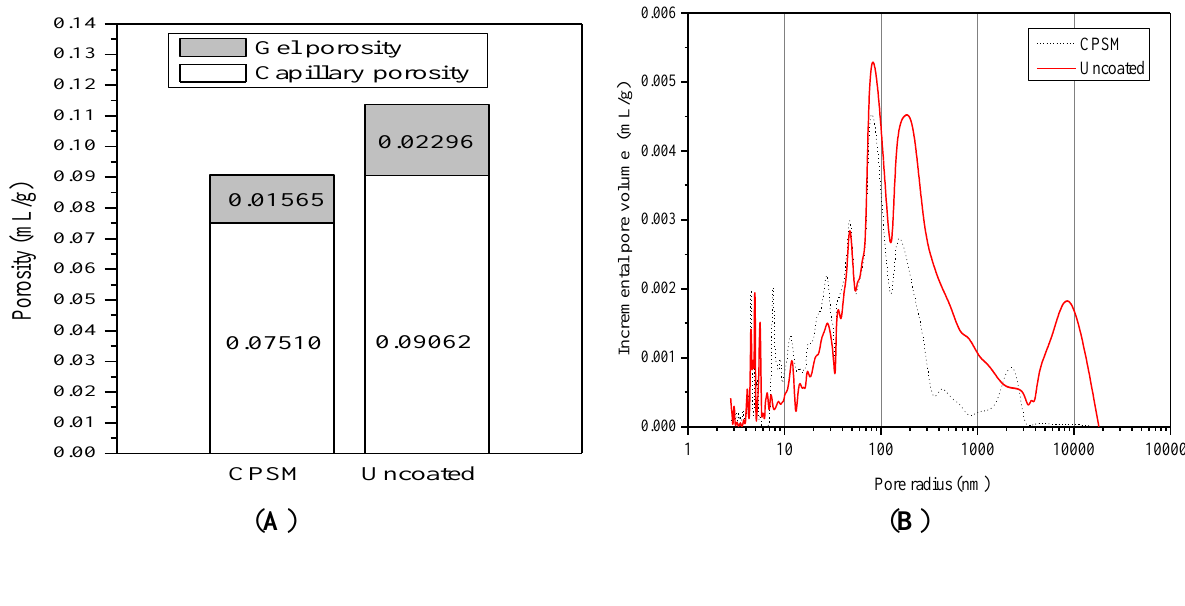
Figure 3. Mercury intrusion porosimetry (MIP), the volume and the volume distribution of pores. ( A ) volume change of pores; ( B ) volume distribution of